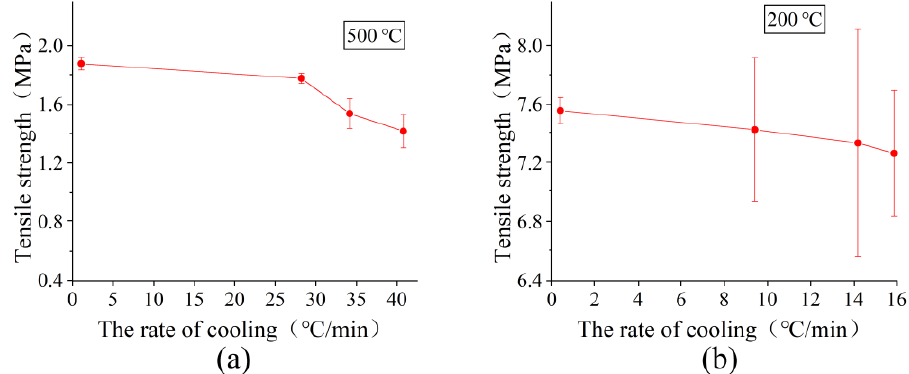
Figure 9. Variation of tensile strength of granite samples with cooling rates: ( a ) after heating at 500 °C; ( b ) after heating at 200 °C (error bars denote standard deviation).